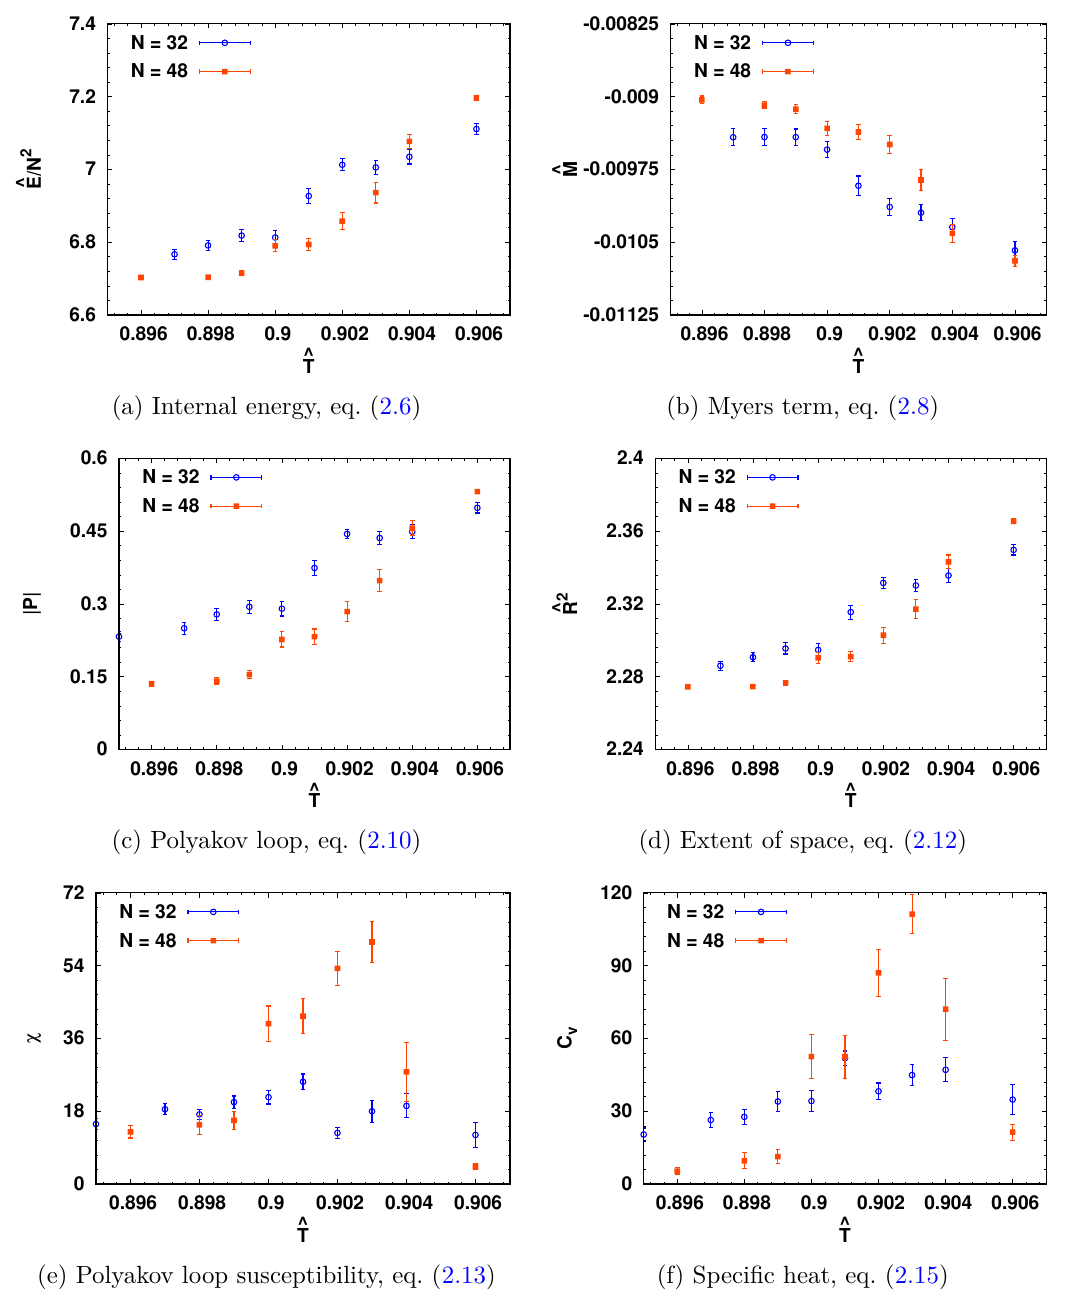
Figure 1. The six observables discussed in the text, for temperatures 0 . 896 ≤ b T ≤ 0 . 906 around the transition. As N increases from 32 to 48 there is clear growth in the Polyakov loop susceptibility and the specific heat peaks in the final